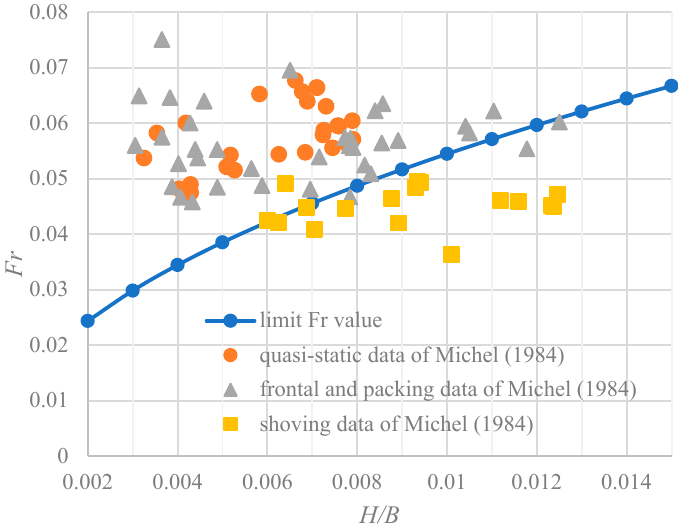
Figure 10. Calculated limiting flow Froude number Fr for natural rivers compared to those of field observations of the St. Lawrence River and Beauharnois Canal.